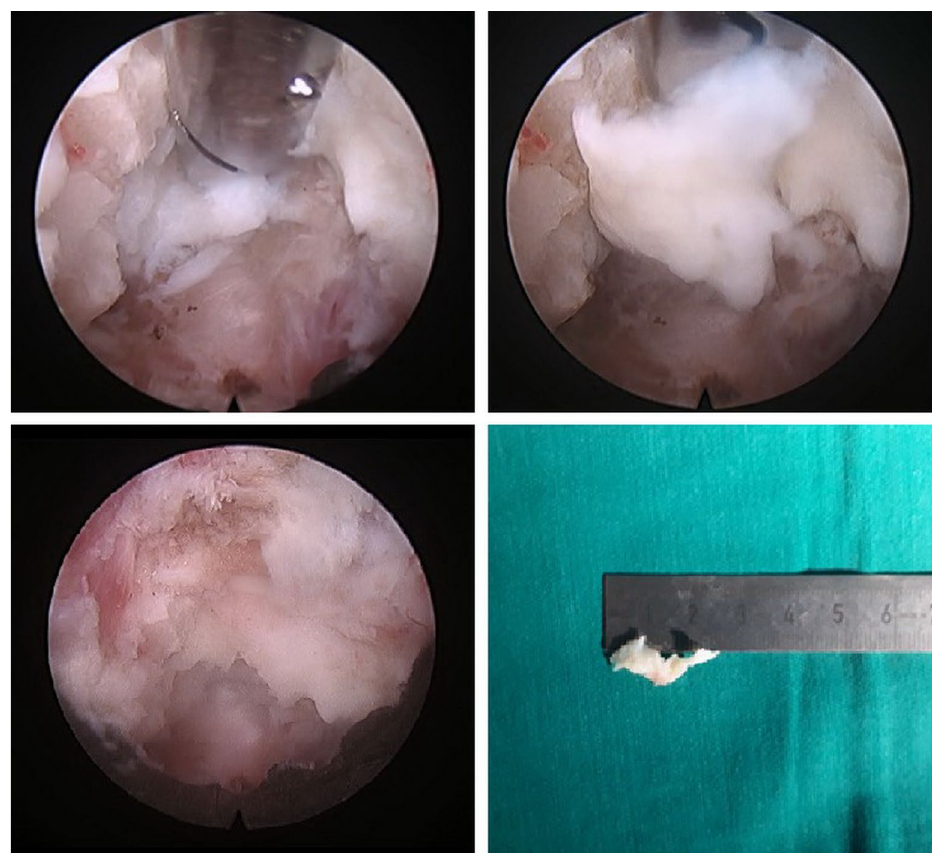
Figure 5. Preparation and removal of the herniated